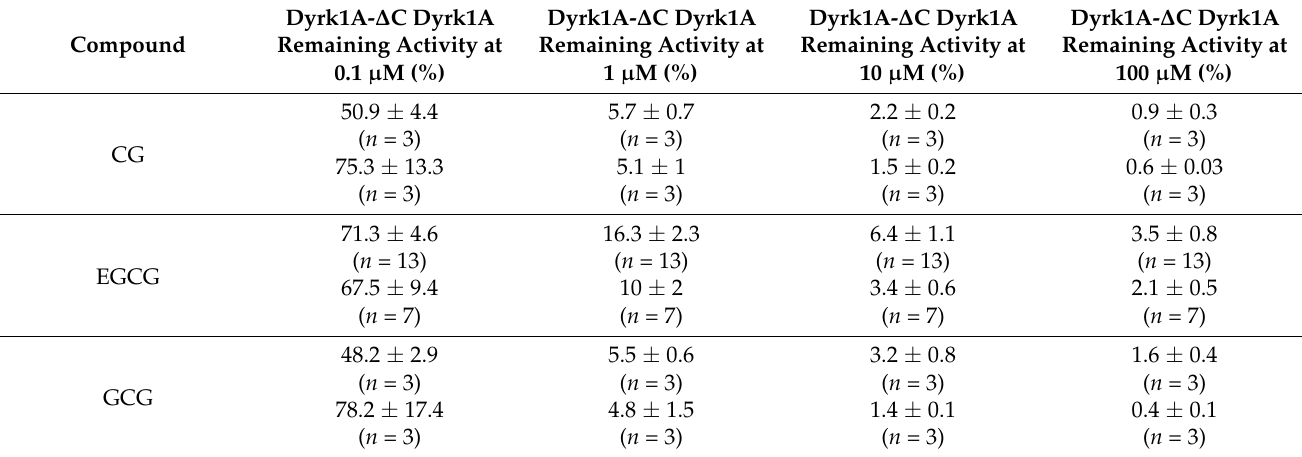
Table 1. Dyrk1A- ∆ C and Dyrk1A inhibition assays at different concentrations using HPLC-based assays.